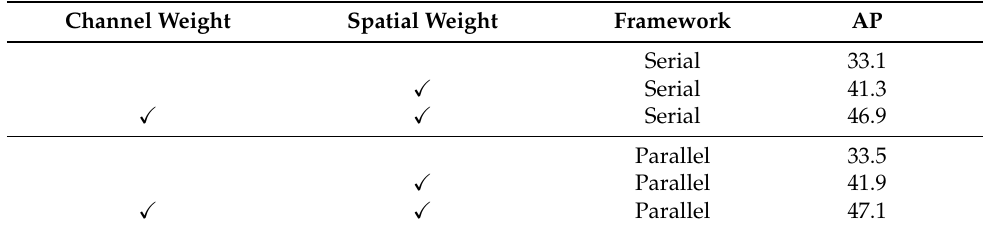
Table 4. Comparison between different frameworks for proposed improved dual attention module. Channel